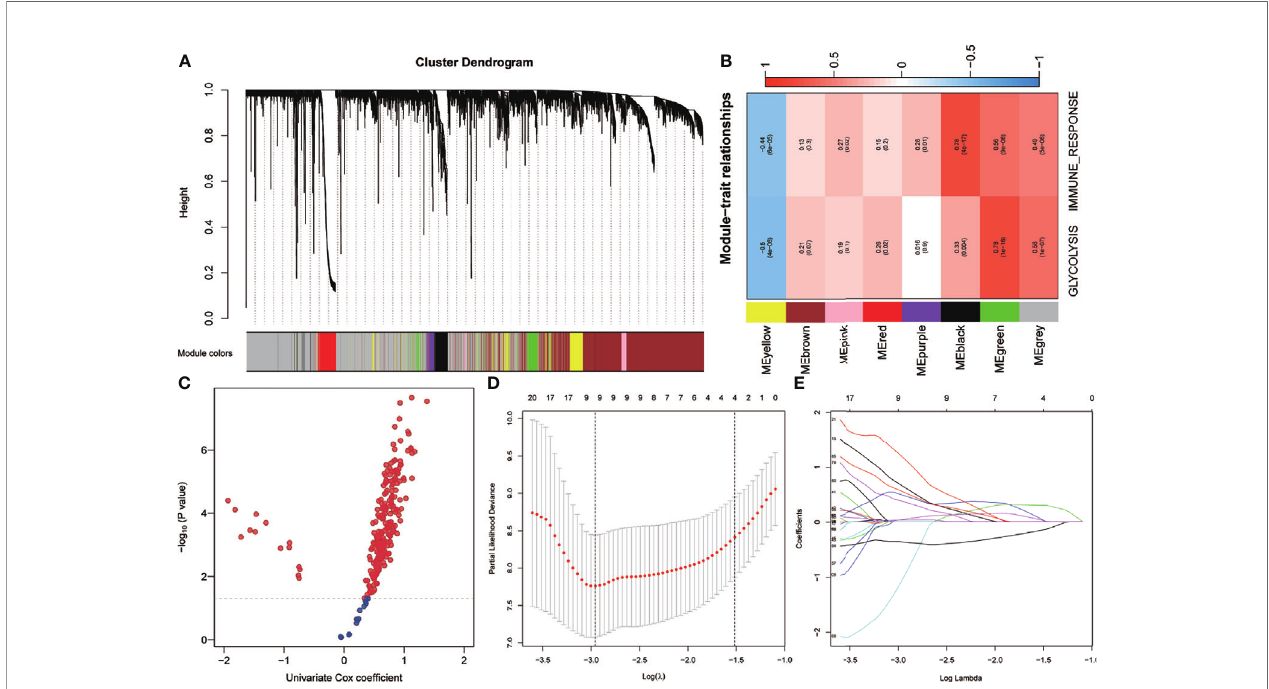
FIGURE 3 | Establishment of genetic signatures related to glycolysis and immune response. (A) The variance of the expression value of each gene in the training set was calculated, and then the top 6,000 genes in the variance ranking were used to construct the WGCNA network. Seven non-gray modules were identi fi ed. (B) The green module depicting the highest correlation ( r > 0.5, p < 0.0001) was considered the most correlated with glycolysis and immune response. (C) Using univariate Cox regression analysis, 238 prognostic-related candidate genes were extracted from the key genes from the green module. (D, E) The LASSO Cox regression model was used to identify the most robust biomarkers, and multivariate Cox stepwise regression was applied to construct a prognostic model. LASSO , minimum absolute shrinkage and selection operator; WGCNA , weighted gene co-expression network